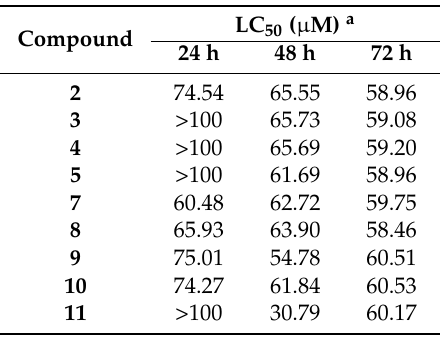
Table 1. Antileishmanial efficacies of isobenzofuranones against